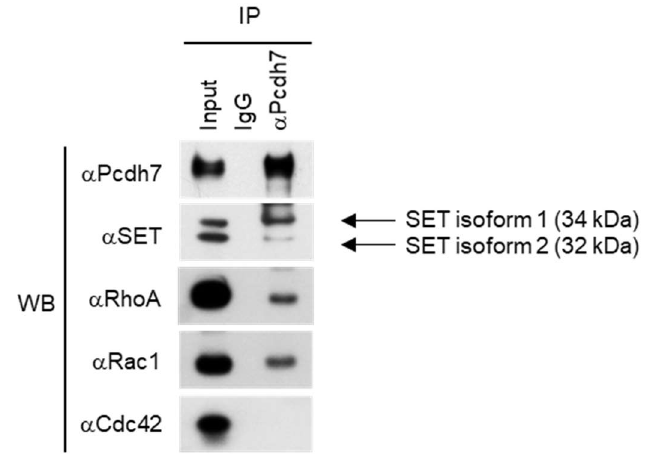
Figure 1. Pcdh7 associates with SET and small GTPase RhoA and Rac1. Total cell lysates were prepared from wild-type pre-osteoclasts cultured with M-CSF + RANKL for a day and used for immunoprecipitation (IP) and Western blotting (WB) with the indicated antibodies. IgG was used as a negative control antibody. Arrows indicate SET isoforms 1 and 2.